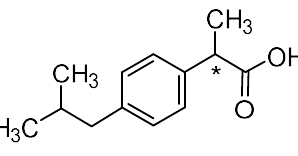
Figure 1. Chemical structure of ibuprofen.